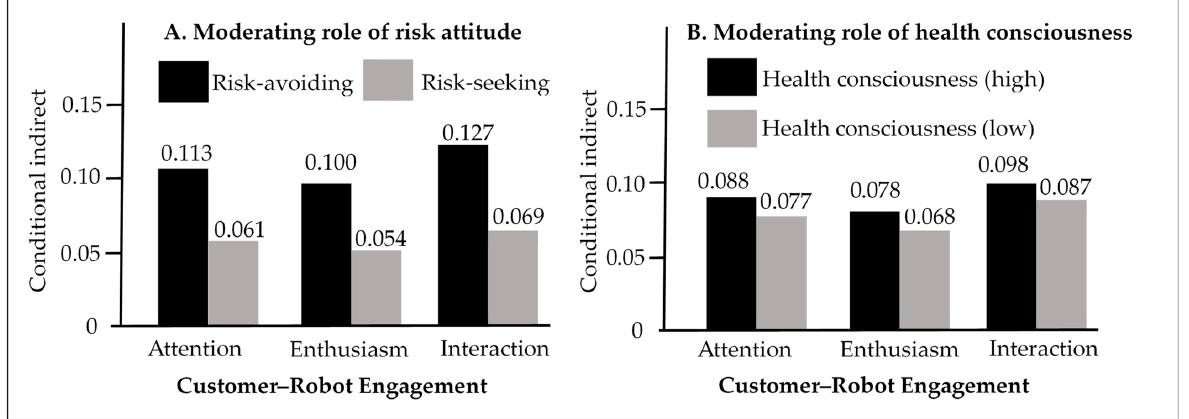
Figure 3. Conditional indirect effect. ( A ) Moderating role of risk attitude. ( B ) Moderating role of health consciousness.